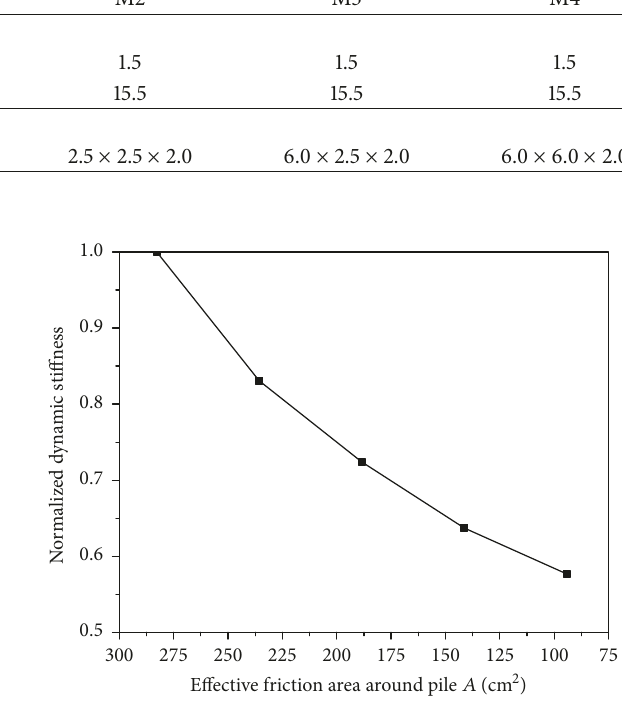
Figure 11: The normalized dynamic stiffness change with effective friction